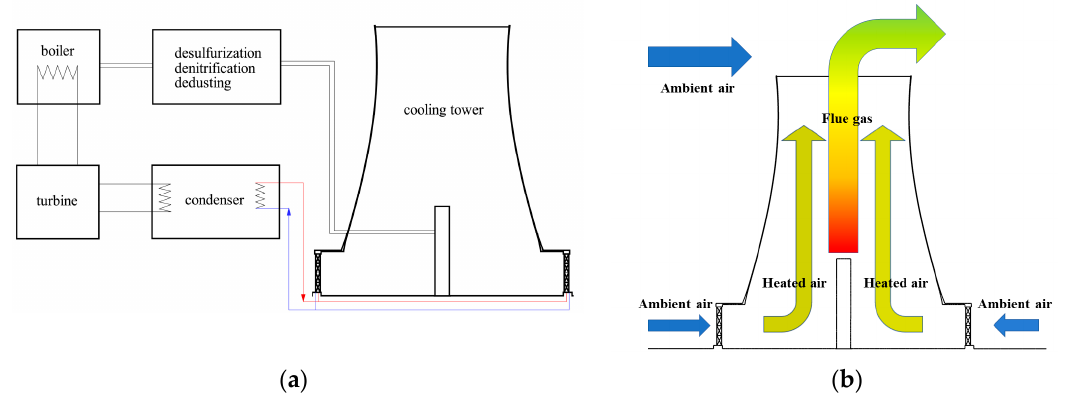
Figure 1. Schematic diagram of a power plant with flue gas discharge: ( a ) operation diagram of coal-fired generating set; ( b ) schematic diagram of flue gas emission in natural draft dry cooling tower (NDDCT) with flue gas injection.